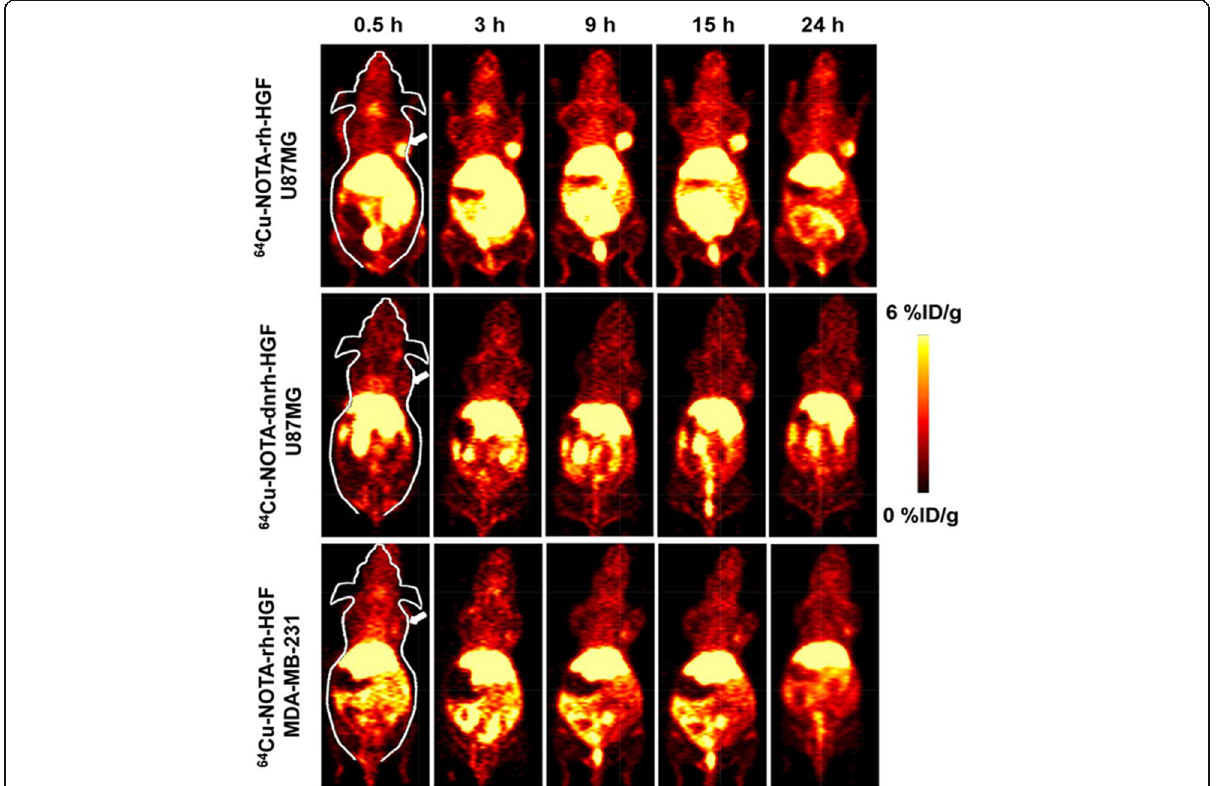
Fig. 2 Coronal micro-PET images of c-Met expression in U87-MG and MDA-MB-231 bearing mice at serial timepoint post-injection of 64 Cu-NOTArh-HGF or 64 Cu-NOTA-dnrh-HGF are shown, and tumors are indicated by arrows . With permission from reference